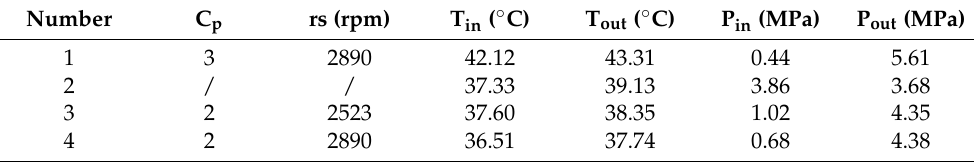
Table A2. GA simulation operation